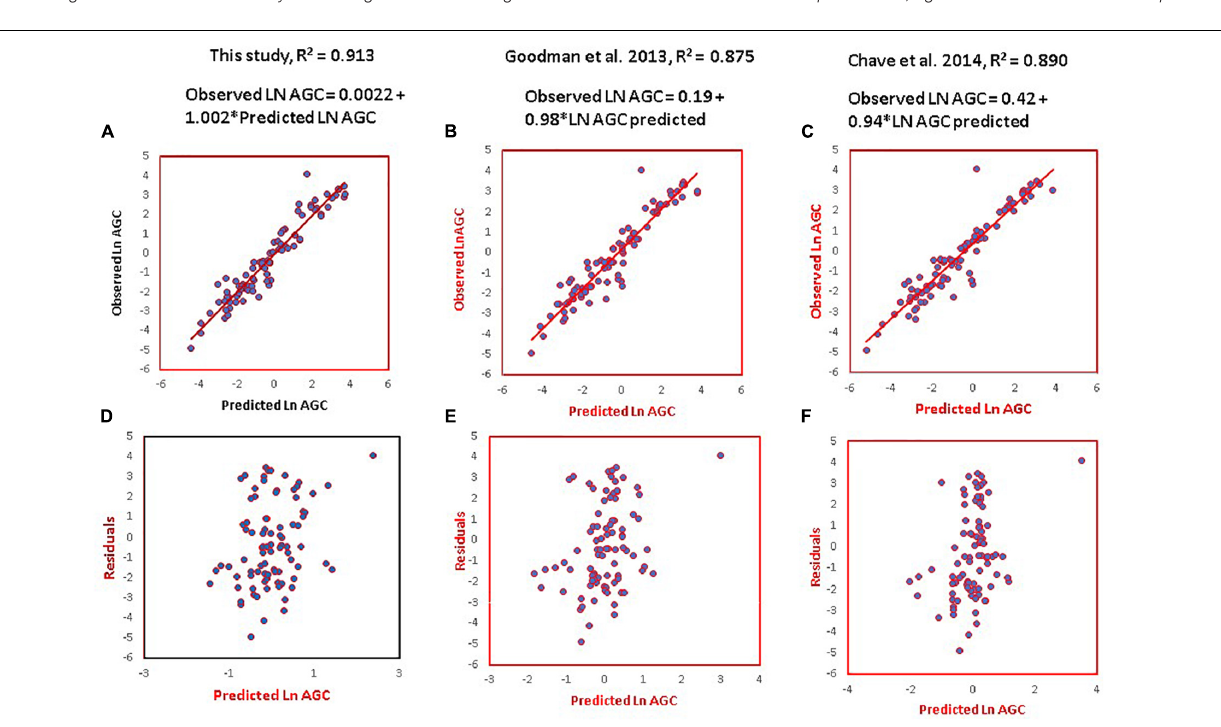
FIGURE 2 | Predicted vs. observed values (A–C) and residuals (D–F) of the Ln of AGC in kg following the general palm model proposed in this study, Goodman et al. (2013)’s model, and the pantropical model of Chave et al.